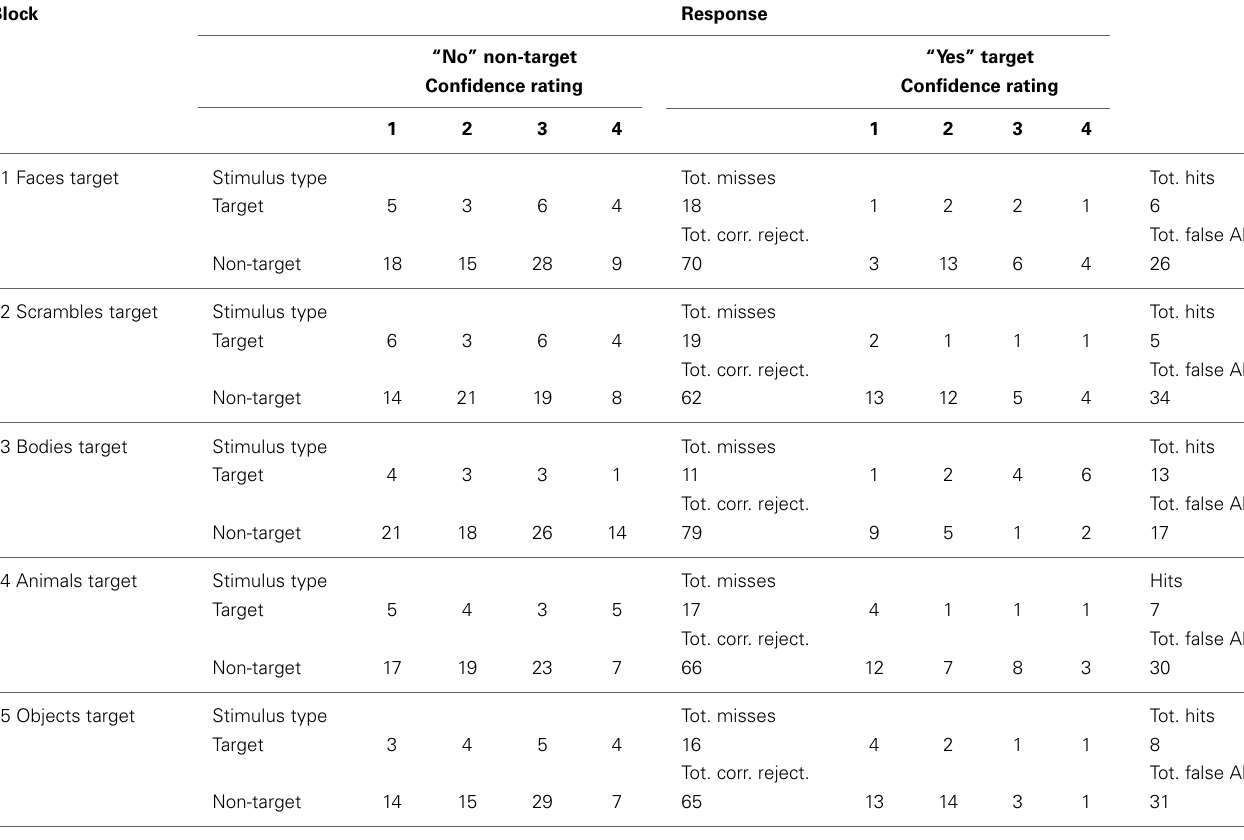
Table 1 | Responses to all stimulus categories and blocks as a function of the 8 possible ratings.